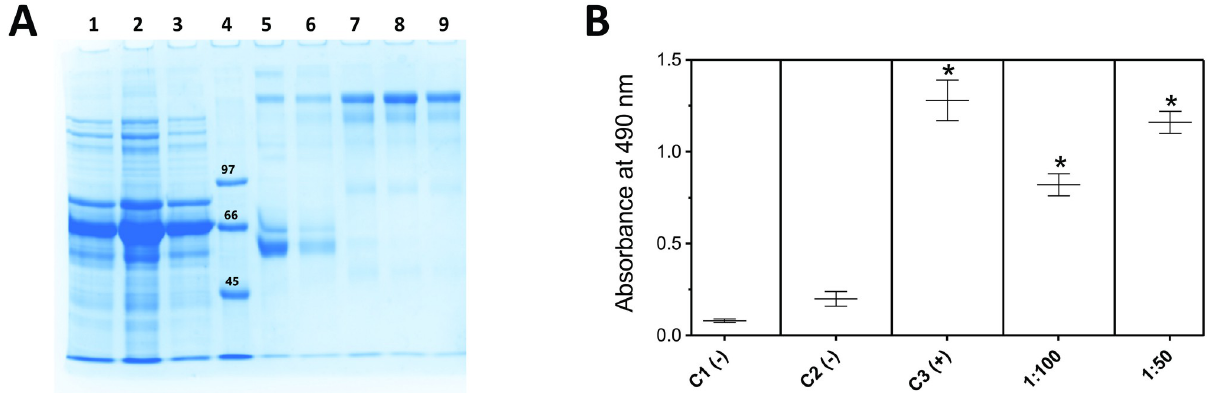
Fig 3. Purification of IgG anti-Ts5 antibodies. (A) SDS-PAGE (8%) under reducing conditions following M2 mice-derived serum IgG isolation. Lane 1: mice serum (M2); Lane 2: void; Lane 3: washing; Lane 4: Molecular mass marker (97.0–14.4 kDa); Lane 5: washing 2; Lane 6: washing 3; Lane 7: Proteins (IgGs) eluted on tube 1; Lane 8: Proteins (IgGs) eluted on tube 2; 9: Proteins (IgGs) eluted on tube 3. SDS-PAGE gel was stained with Coomassie brilliant blue. (B) Immunorecognition of Ts5 toxin by the pooled anti-Ts5 IgGs’ eluted (tubes 1–3). C1(-): wells non sensitized; C2(-): wells sensitized with Ts5 (2 μ g) and tested with non-immune mouse serum; C3(+): wells sensitized with mouse non-immune serum; 1:100 and 1:50: wells sensitized with Ts5 (2 μ g) and tested with purified mouse anti-Ts5 IgGs. Rat anti-mouse-HRP antibodies were used in the ELISA detection. The ELISA assay was performed in duplicate, and results are plotted as mean ± SD. Data was analyzed using one-way ANOVA and Tukey’s post hoc test. Graph was generated using GraphPad Prism Version 9.3.1. � p < 0.05, when compared to negative controls.